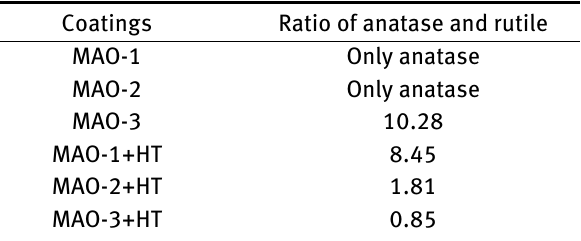
Figure 3: XRD patterns for three MAO coatings formed onto Ti substrates, (a) before heat treatment, (b) after heat treatment